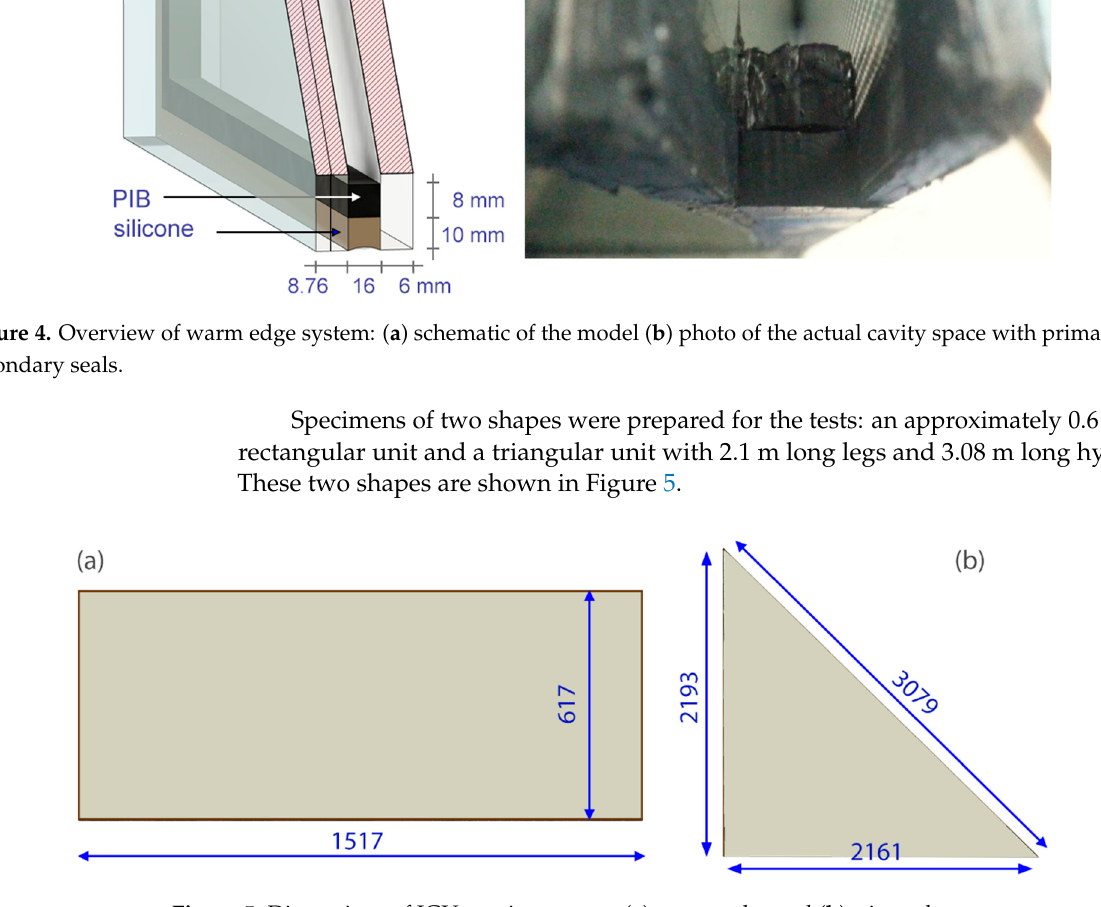
Figure 5. Dimensions of IGU specimens, mm ( a ) rectangular and ( b )